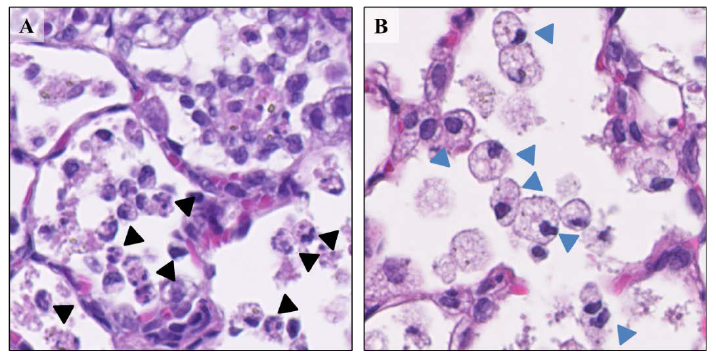
Figure 4. Lung samples sectioned with H&E staining exposed to nanomaterials intratracheally. ( A ) the NiO-high dose exposed group; ( B ) the CeO 2 -high dose group. There were differences of infiltrating inflammatory cells between nanomaterials. While mainly neutrophils and macrophages were found in the alveoli in the NiO-high dose group ( A ), macrophage-based inflammatory cell infiltration was observed in the CeO 2 -high dose group ( B ). Black arrow heads indicate neutrophils and blue arrow heads indicates macrophages. Nanomaterials 2020 , 10 , x FOR PEER REVIEW